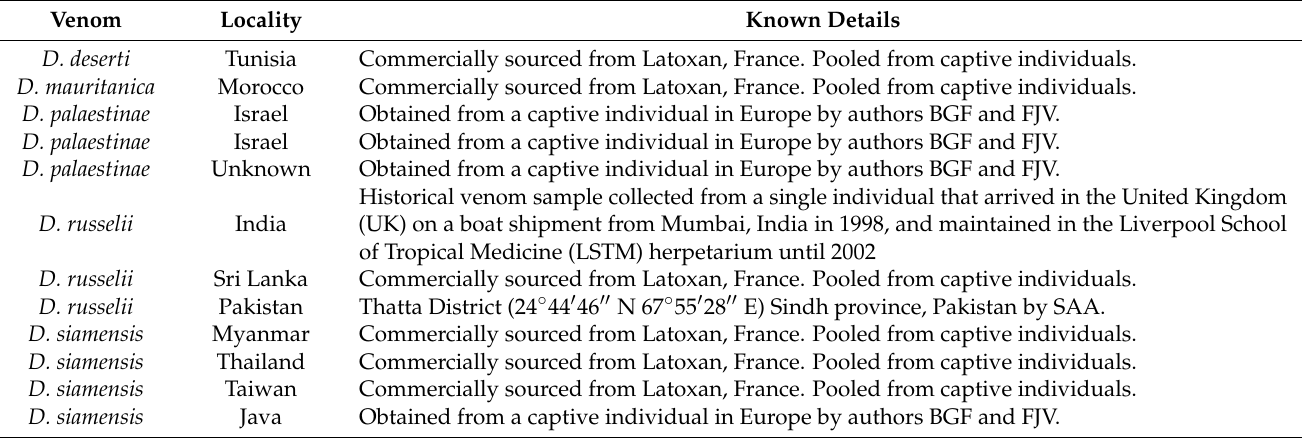
Table 1. Details of the venoms used for the study. All venoms were from adult